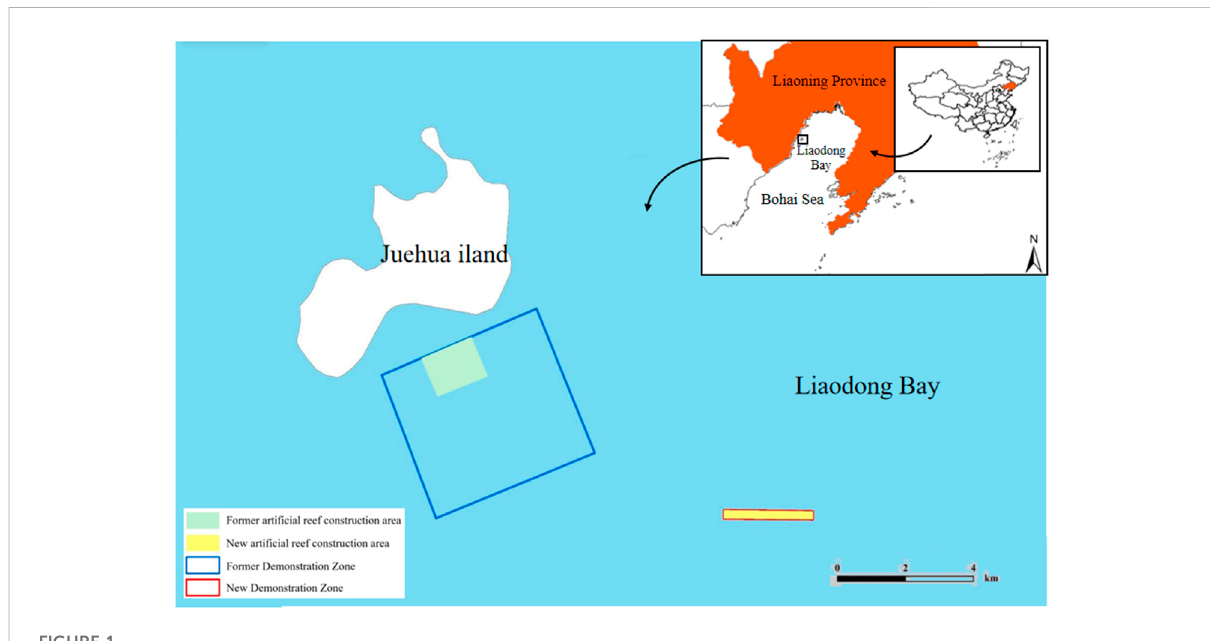
FIGURE 1 Location of the study